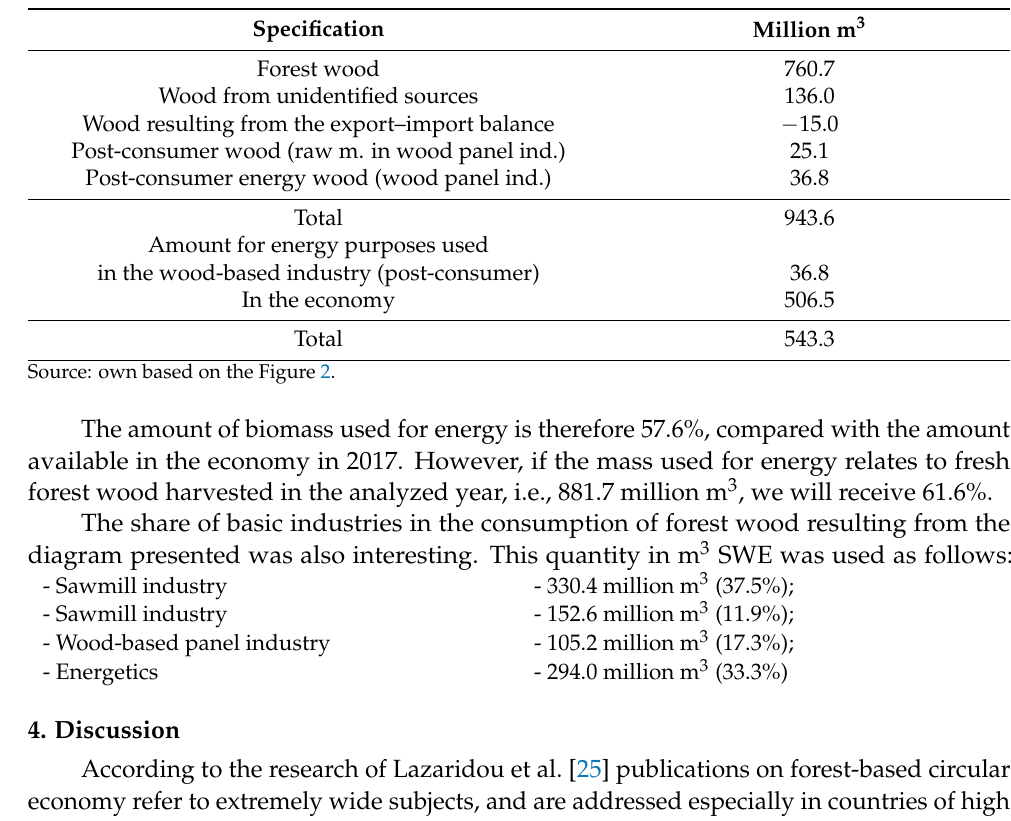
Table 2. Raw wood material distribution in Europe in